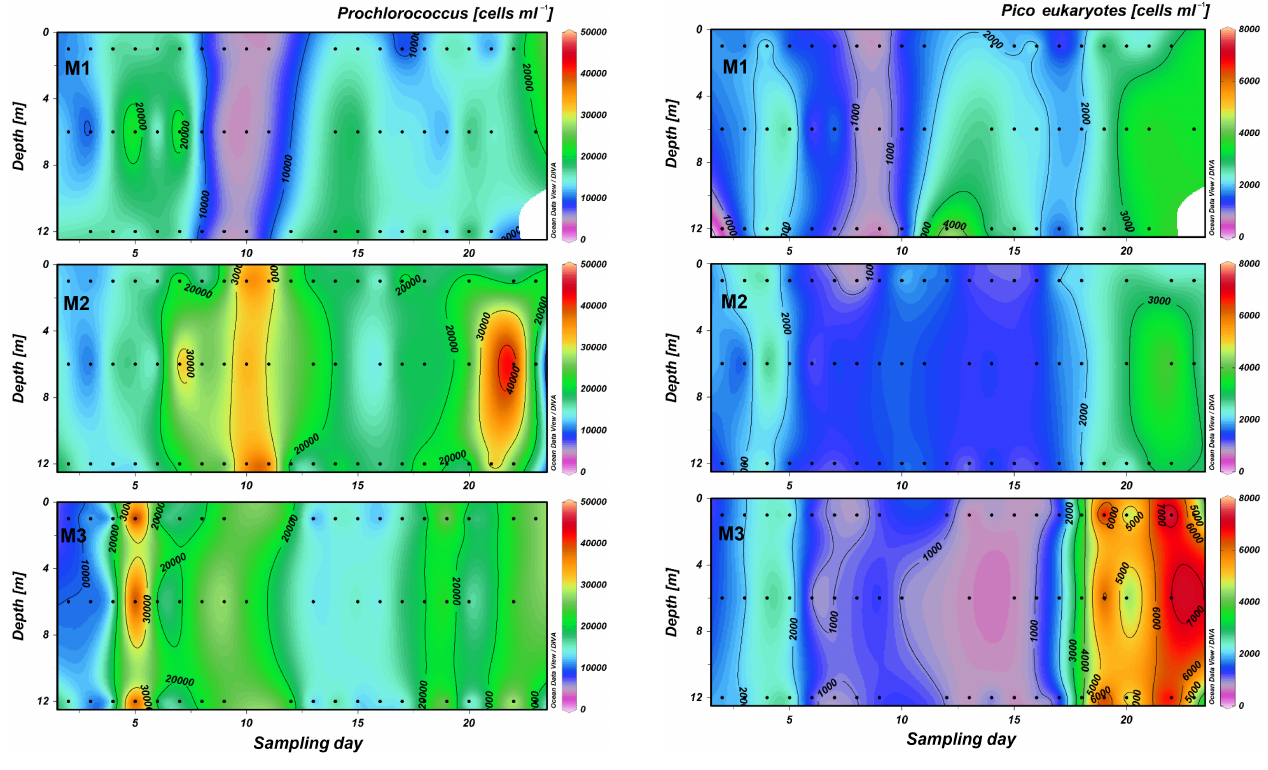
Figure 5. Prochlorococcus in cellsmL − 1 at each of the three depths (1, 6 and 12m) inside each mesocosm (M1, M2 and M3).